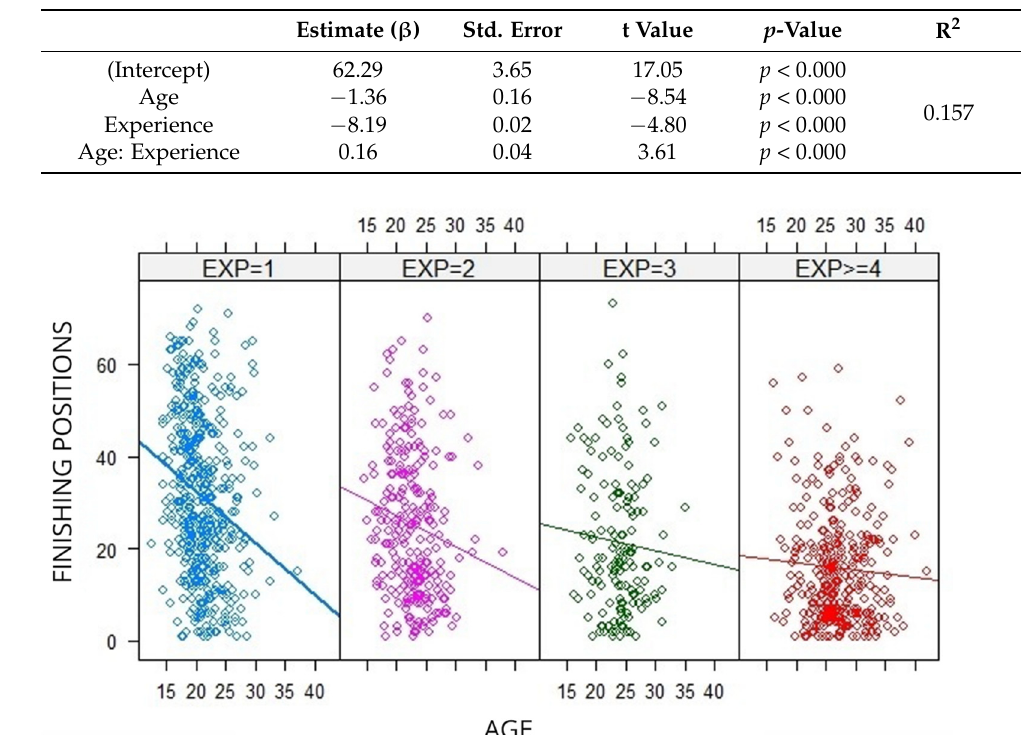
Table 2. Regression analyses for finishing positions in the 10-km races of the WCH and OG since 2000, based on age and experience of swimmers.